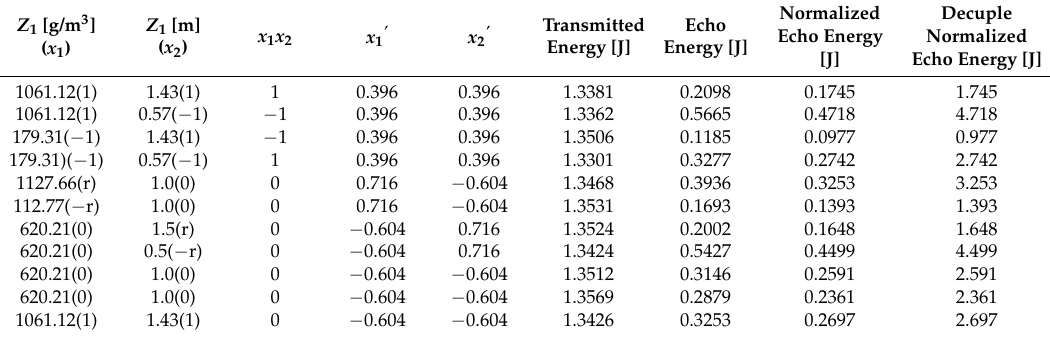
Table 5. Results of canopy density model experiments with three layers of